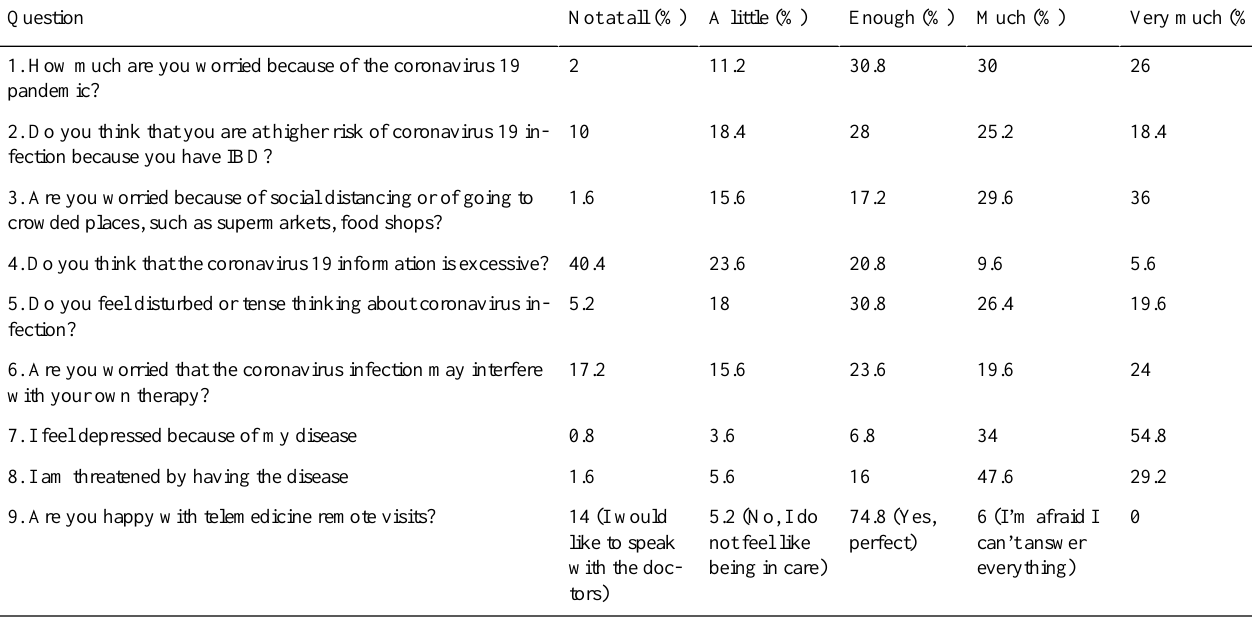
Very much (%)Much (%)Enough (%)A little (%)Not at all (%)Question